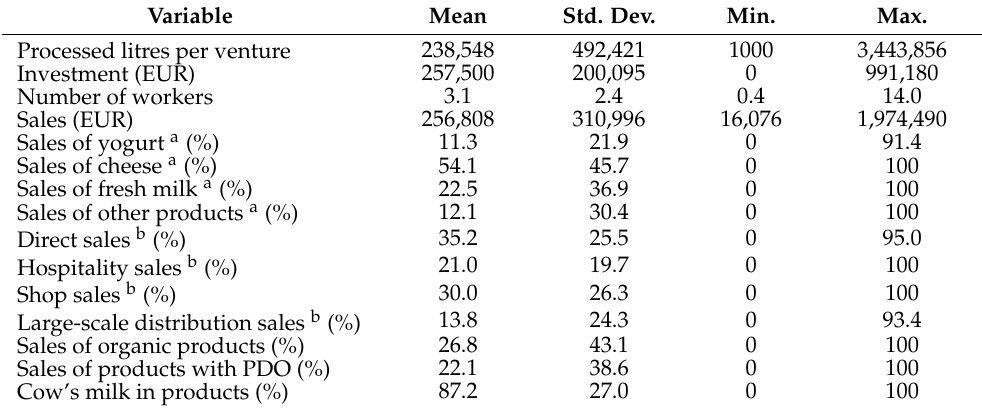
Table 1. Descriptive statistics of the 49